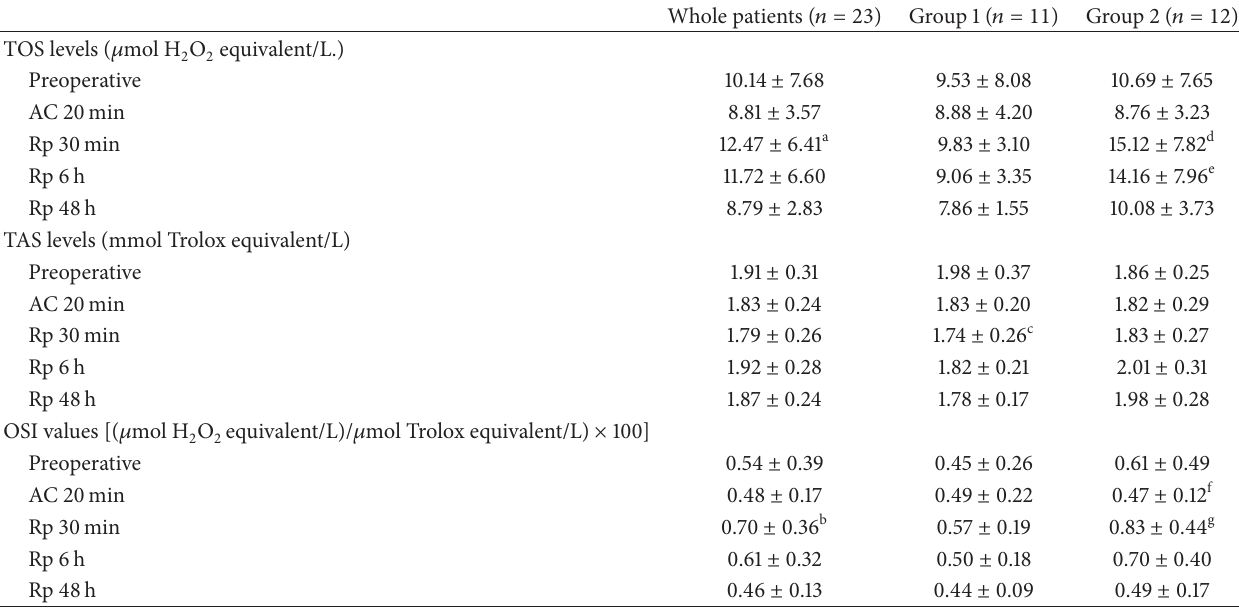
Table 3: TOS, TAS, and OSI values of